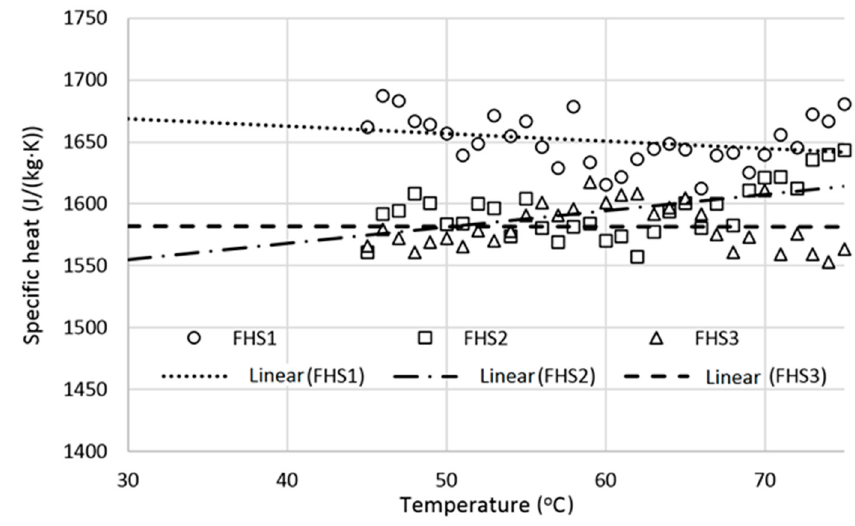
Figure 4. Specific heat vs. temperature for FHS samples. Materials 2020 , 13 , x FOR PEER REVIEW